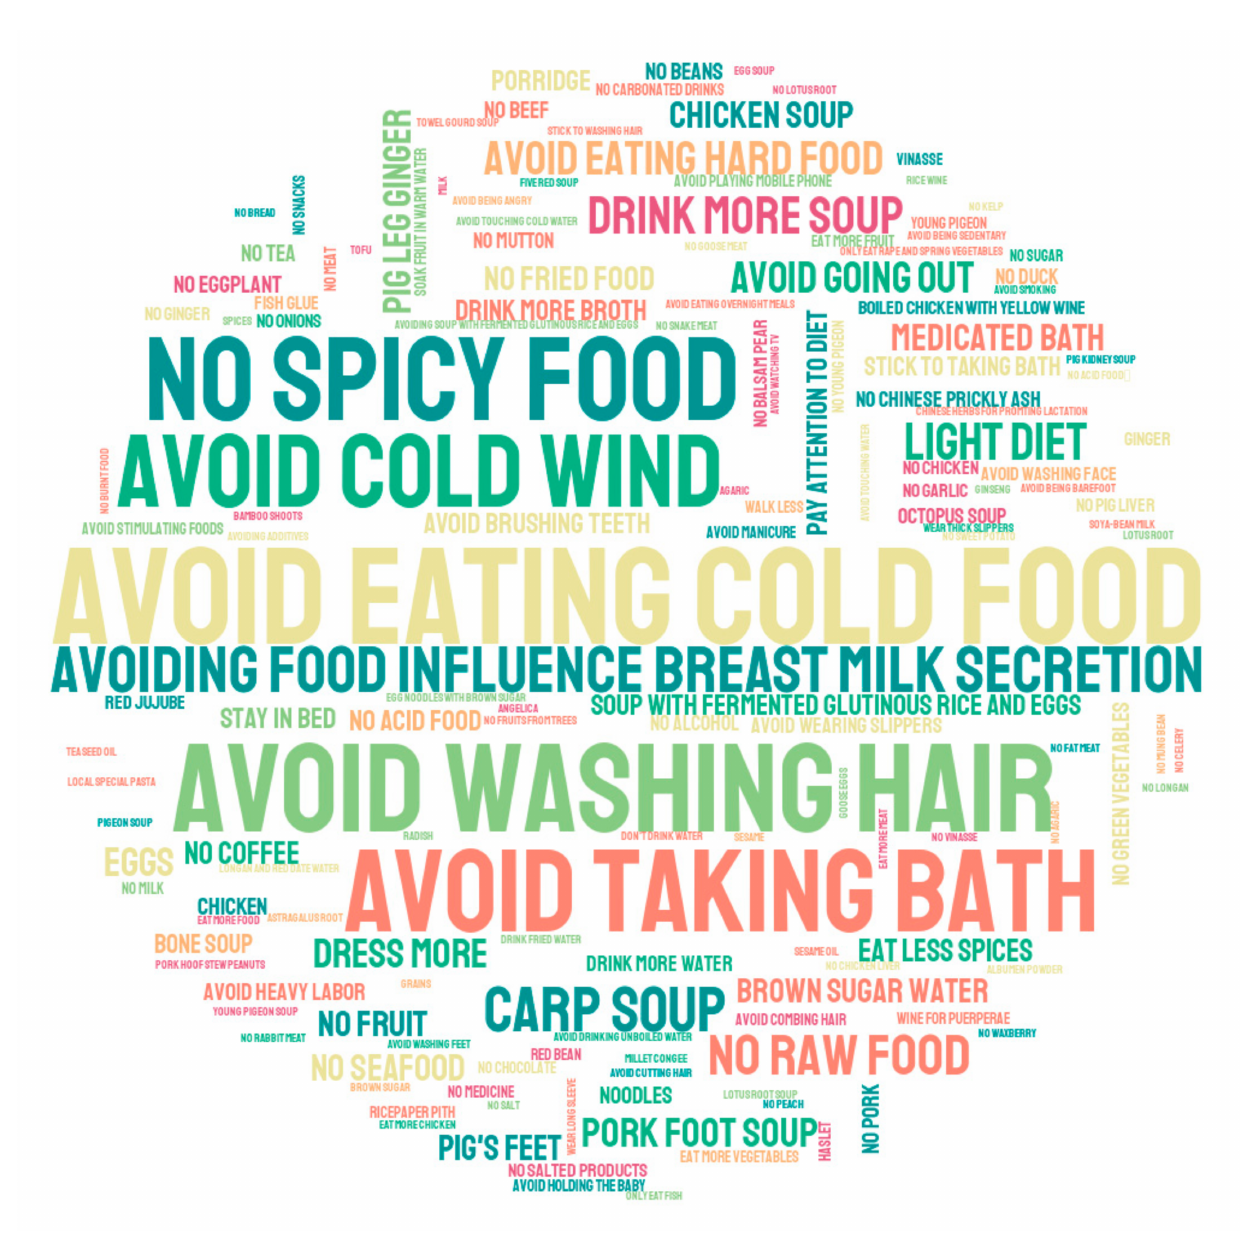
Figure 1. The traditional postpartum practices reported by lactating women in 10 cities of China. A larger word size indicates a higher reported